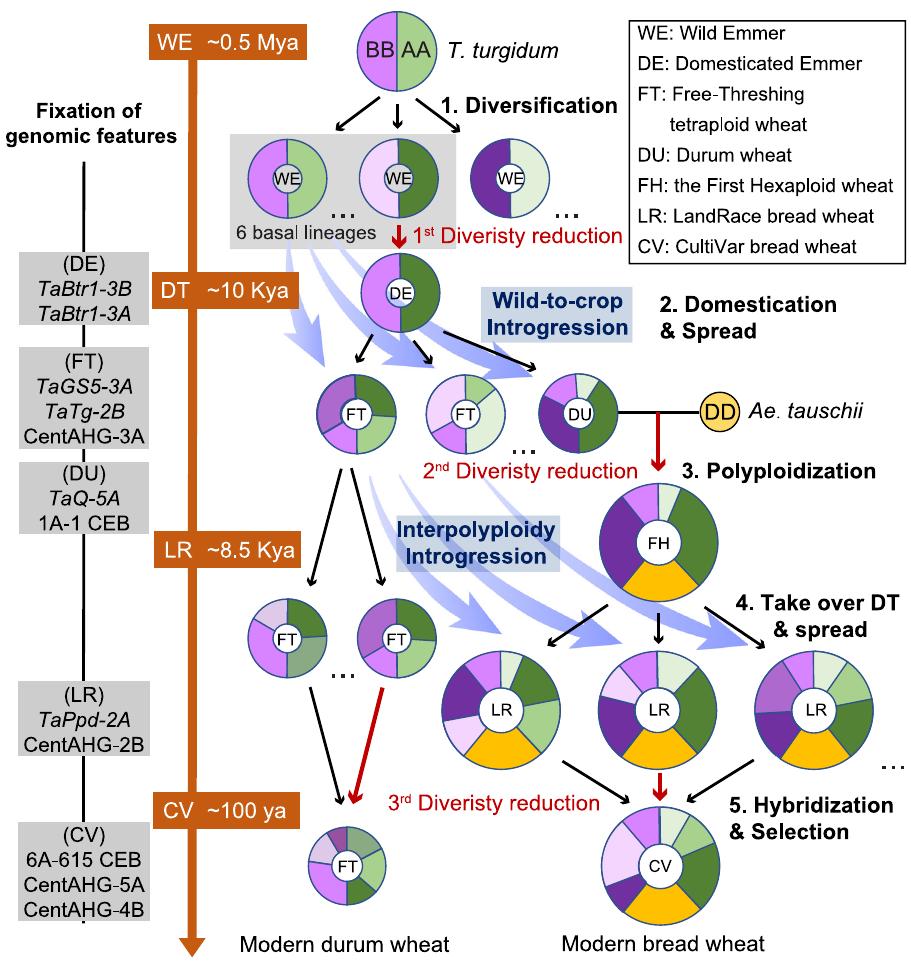
Fig. 6 Schematic illustration of the dispersed emergence and protracted domestication of polyploid wheat. The evolutionary scenario of modern domesticated wheat from initial tetraploid wheat (right), and the corresponding time scale (middle). Purple, green and yellow sectors denoting the A, B and D subgenomes, respectively, and the types of AHGs were discriminated by their brightness. Succinct descriptions of fi ve major steps are denoted with serial numbers. Arrow colors indicate the phylogenetic relatedness between taxa. Black, direct pedigree. Blue, genetic introgression. Red, major genetic diversity reduction. The genomic features fi xed in each group were noted (left). This schema is based on the results from this study and prior assumptions from the